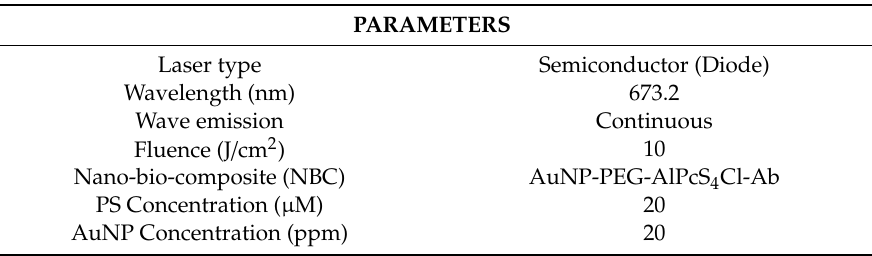
Table 5. NBC and laser parameters using the 673.2 nm diode